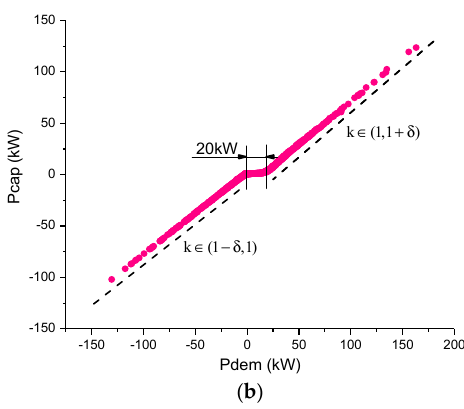
Figure 11. Convex optimization results: ( a ) power distribution results based on convex optimization; and ( b ) the relationship between power demand and SC power.